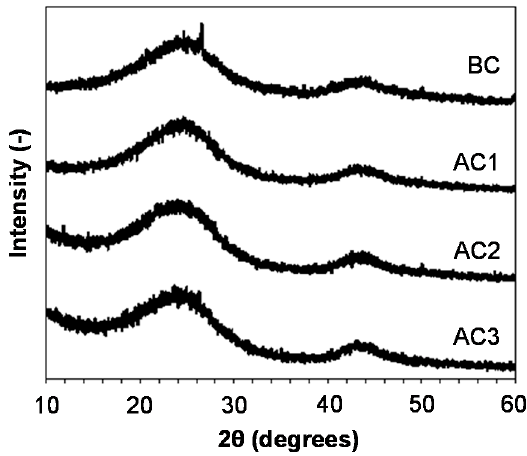
Figure 4. XRD patterns of biochar and activated carbon.